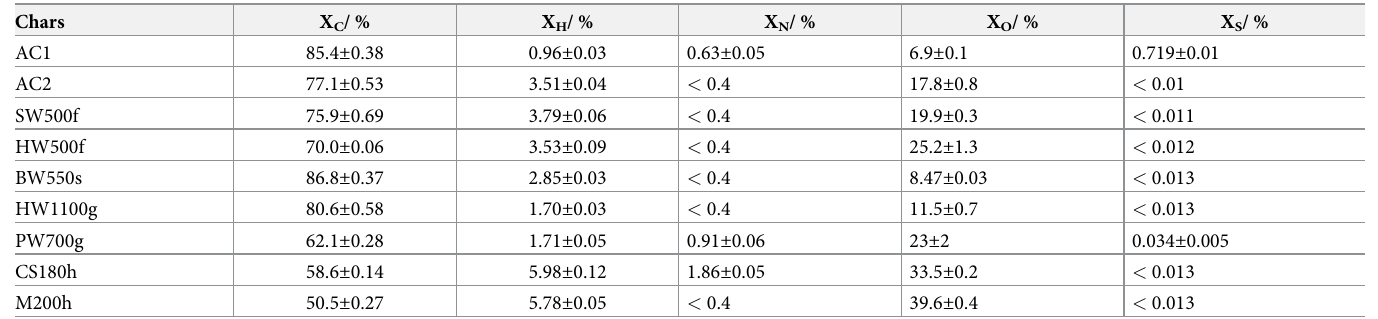
Table 2. Composition of chars in weight per weight %.